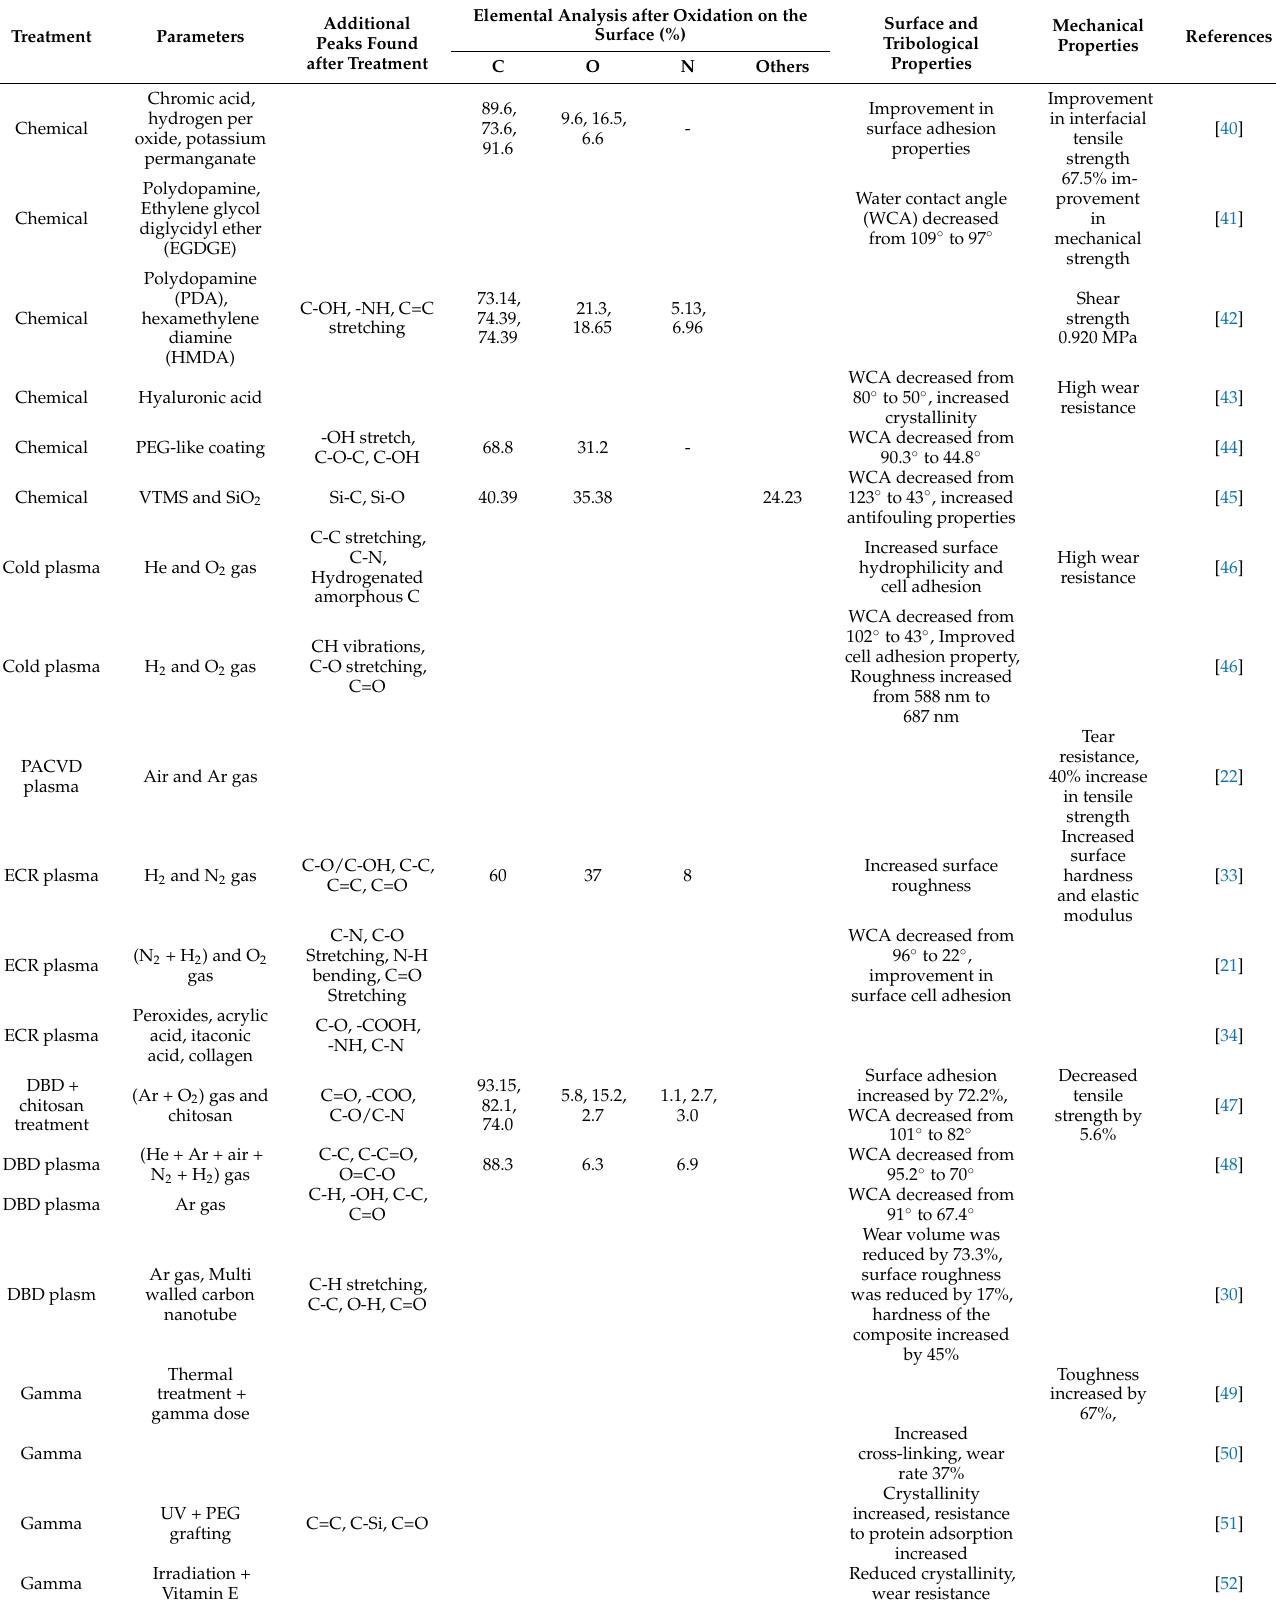
Table 1. The influence on surface properties of UHMWPE after surface